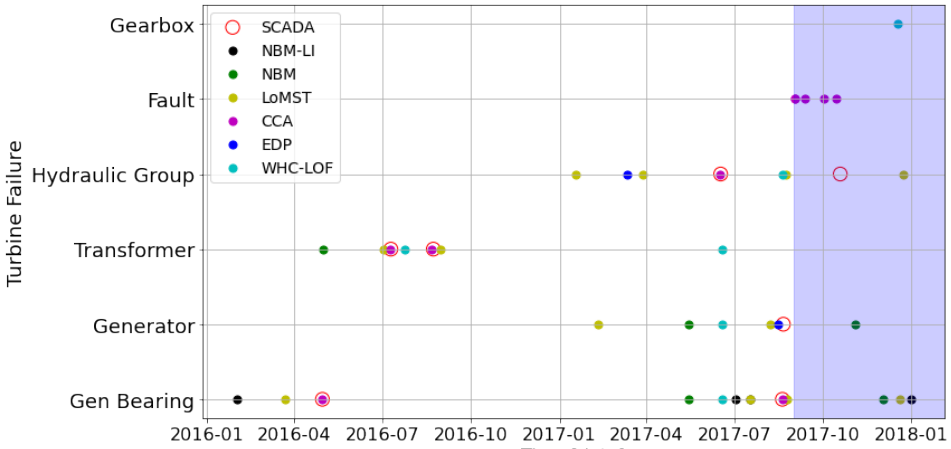
Figure 10. Comparison of fault predictions for each model for WT07.